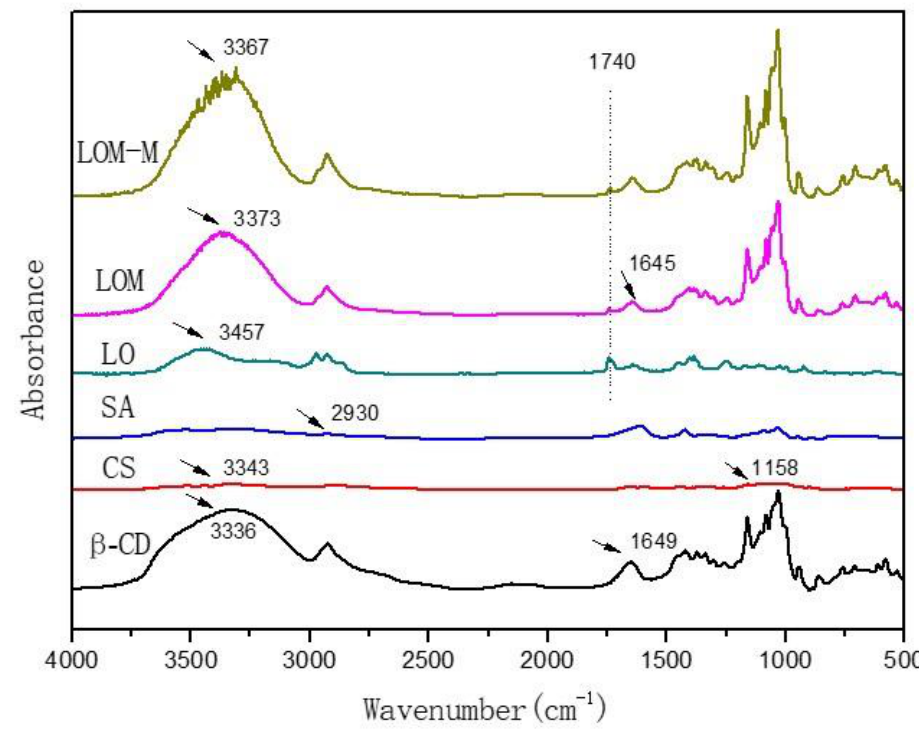
Figure 3. Fourier-transform infrared (FT-IR) spectroscopy of β -cyclodextrin ( β -CD), chitosan (CS), sodium alginate (SA), lavender essential oil (LO), single-layered microcapsules (LOM) and double-layered microcapsules (LOM-M).